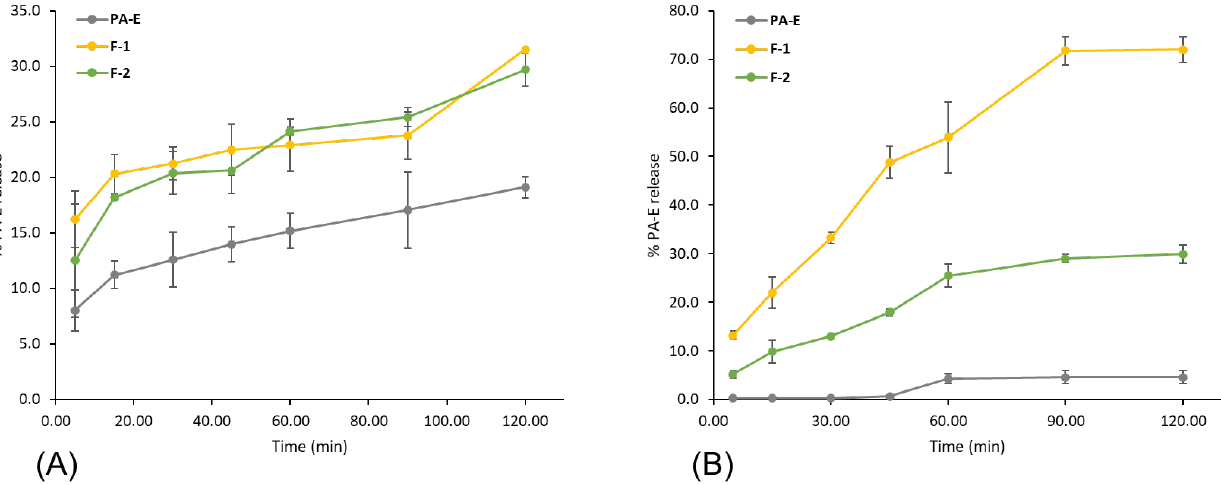
Figure 15. Release profiles of F-1 and F-2 compared to free PA-E dissolution profile in two dissolution media: ( A ) M-1 and ( B ) M-2. Error bars represent the standard deviation of PA-E concentration in the three independent samplings.